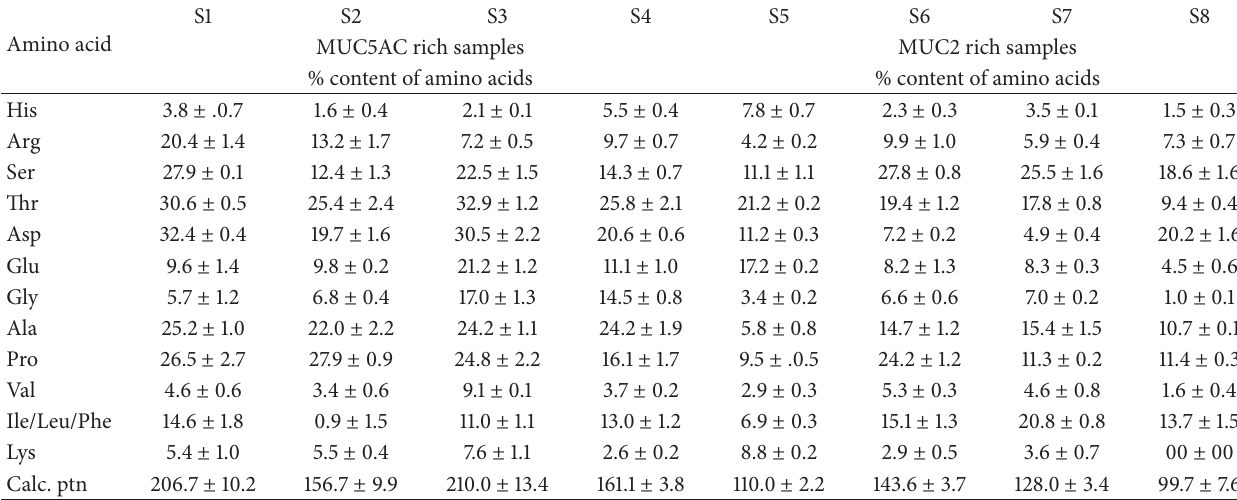
Table 2: Amino acid composition of reduced chronic sinusitis